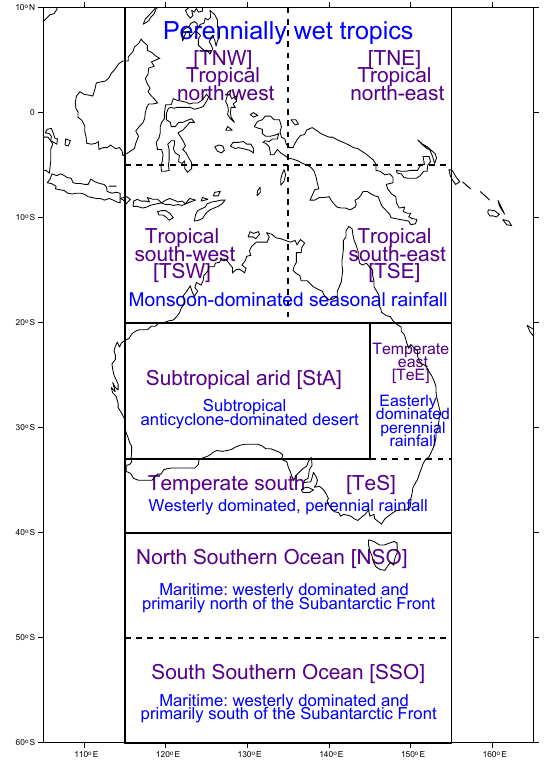
Figure 1. A map of the geographical region under consideration in this paper. Overlaid are the borders and names of the regions re- ferred to in the text and correspond to those of Reeves et al. (2013a). The divisions are also broadly consistent with the climate classifi- cations (Köppen–Geiger) described in Peel et al.